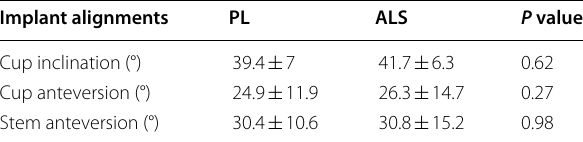
Table 2 Postoperative alignment of implants in the PL and ALS groups